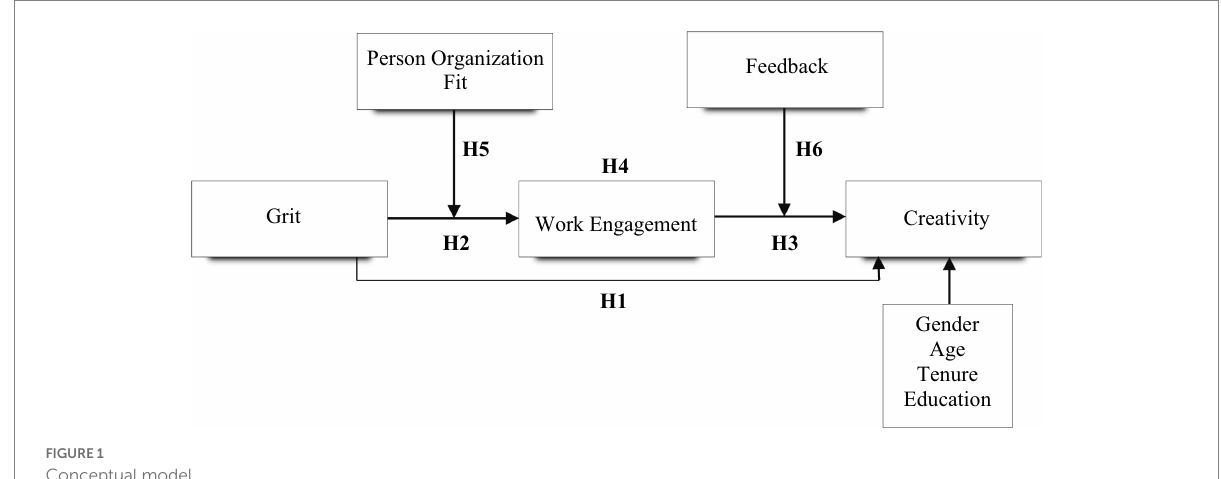
FIGURE 1 Conceptual